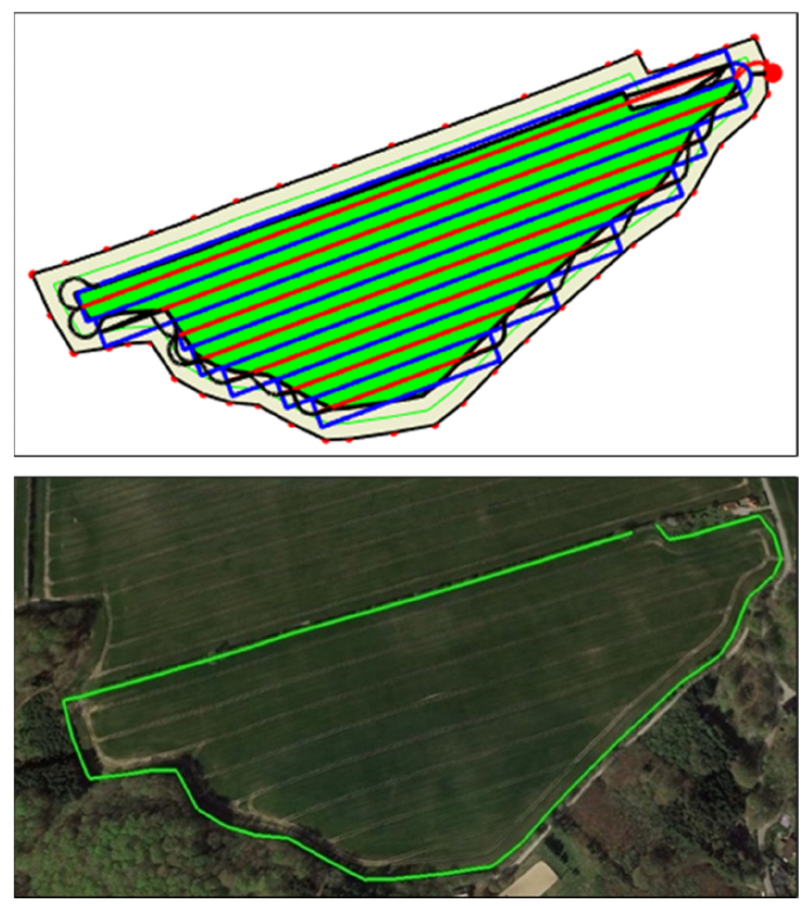
Figure 5. Field representation for sample field 1 with a size of 12 hectares.